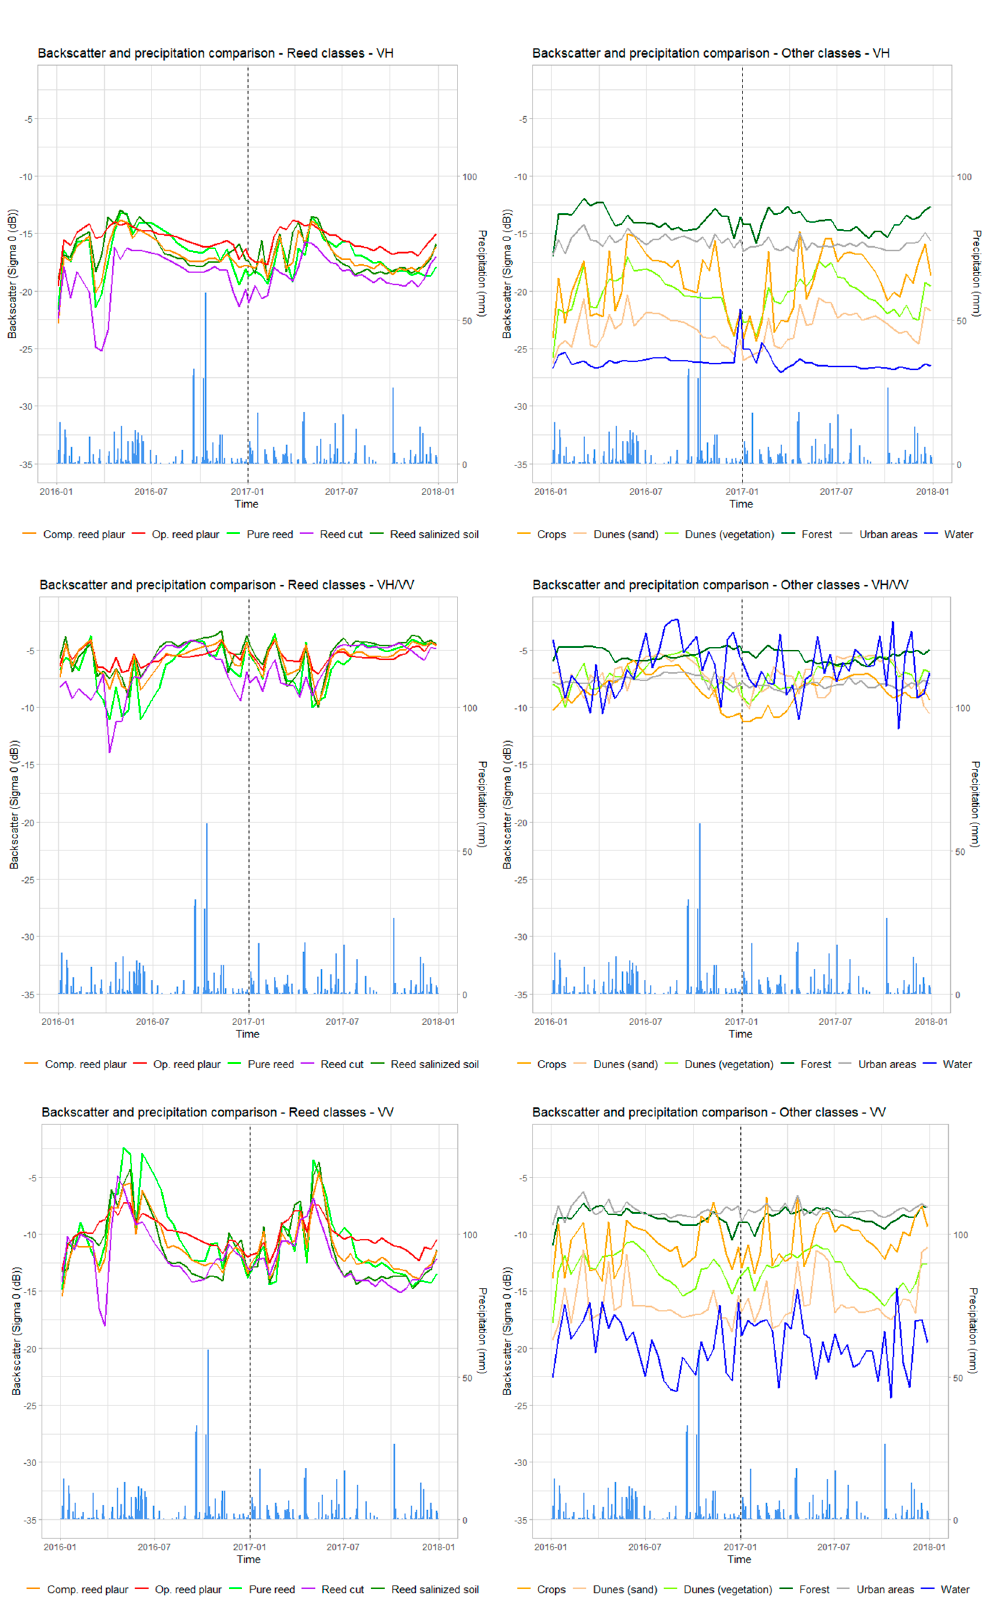
Figure 5. Comparisons of backscattering time series means for di ff erent classes of Phragmites australis and precipitation, over the period 2016–2017. Polarization VH, VV, and VH / VV. On the left the classes of the reed. On the right the other classes of land